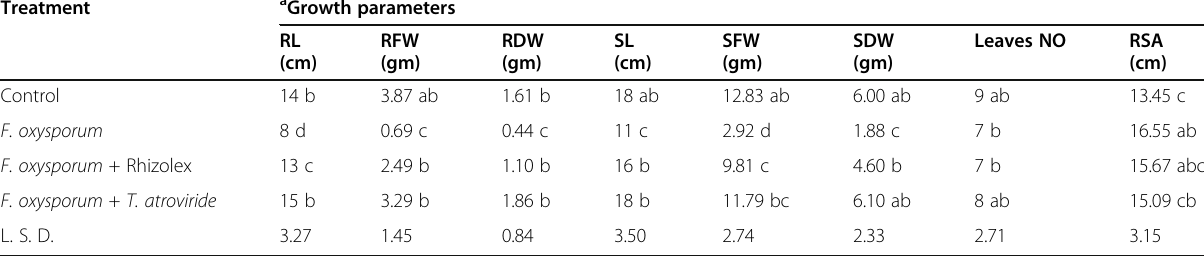
Table 4 Effect of T. atroviride on growth parameters of tomato plant infected by F. oxysporum Treatment